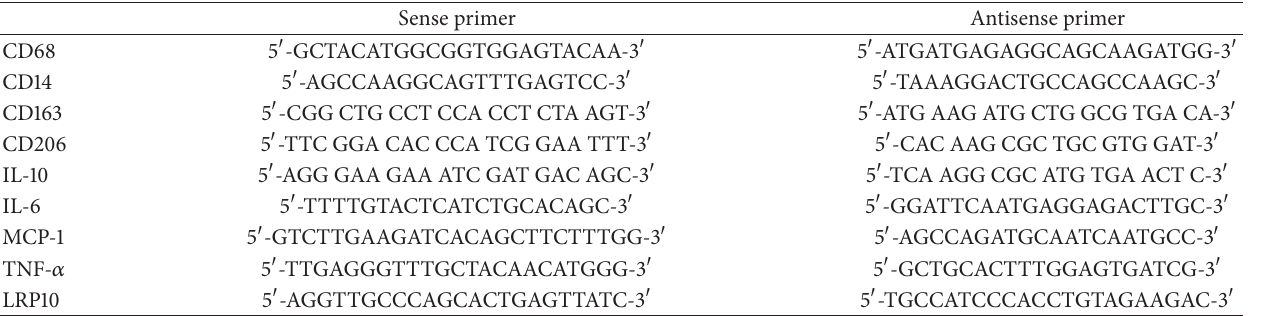
Table 1: Primer pairs used for mRNA determination.